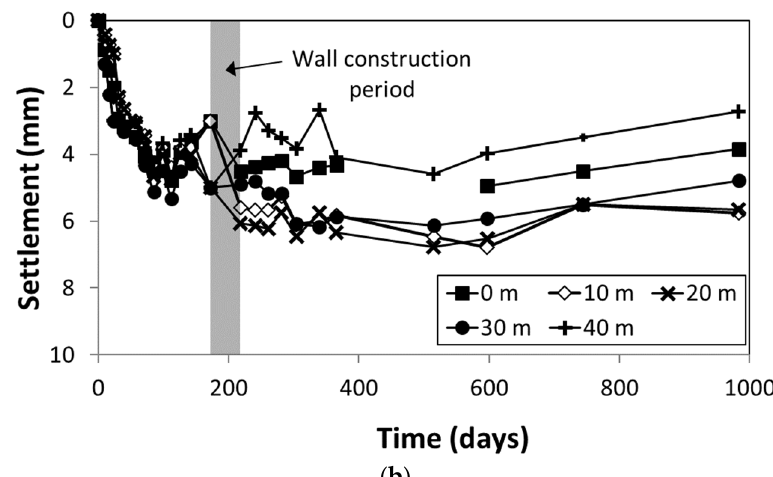
Figure 12. Ground and surface settlements: ( a ) Outer rail; ( b ) Inner rail. The period of increasing settlement can be divided into three parts: backfill stabilization, wall construction, and after wall construction. Figure 13 shows the settlement that occurred according to the measurement period at each measurement point as a percentage of the total settlement. The settlement during the backfill stabilization period compared to the total occurred at 62% and 44% of the ground and surface, respectively, and from 69% to 100% of the interlocking settlement. During the backfill stabilization period, the time-dependent settlement was induced in the soft layer of the bottom ground, owing to the soil weight, and the overall settlement increased with time but showed a tendency to converge at a certain level. The greater the distance from the measurement position to the RSR center of gravity, the greater the rate of settlement during the stabilization period. This can be attributed to the wall load being smaller than the backfill and the wall being installed close to the center of gravity of the RSR.